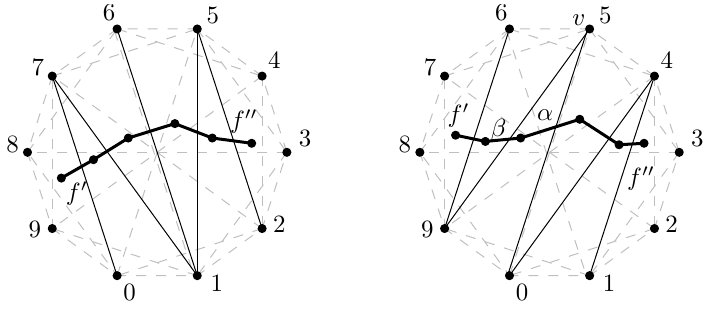
Fig. 5: The caterpillar T , its dual graph D (bold), and the forbidden edges